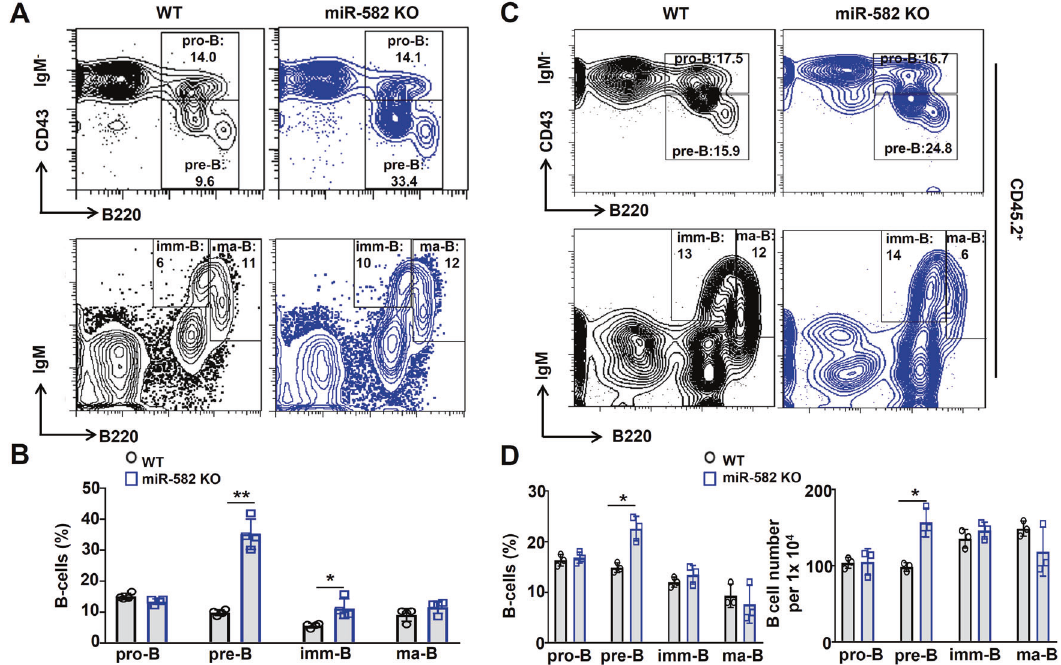
Fig. 3 miR-582 de fi ciency speci fi cally increases pre-B cells in BM. A , B BM cells from miR-582 KO and control mice were analyzed by FACS for pro-B cells, pre-B cells, imm-B cells, and ma-B cells. B cells in each population were compared ( n = 4). C , D Competitive BM transplantation was performed as in Fig. 2A. BM cells were analyzed by FACS for CD45.2 + pro-B, pre-B cells, imm-B, and ma-B cells 2 months after the transplantation. CD45.2 + B cells in each population and cell numbers were compared ( n = 3 – 4). Bars represent means ± SEM, * P < 0.05, ** P <